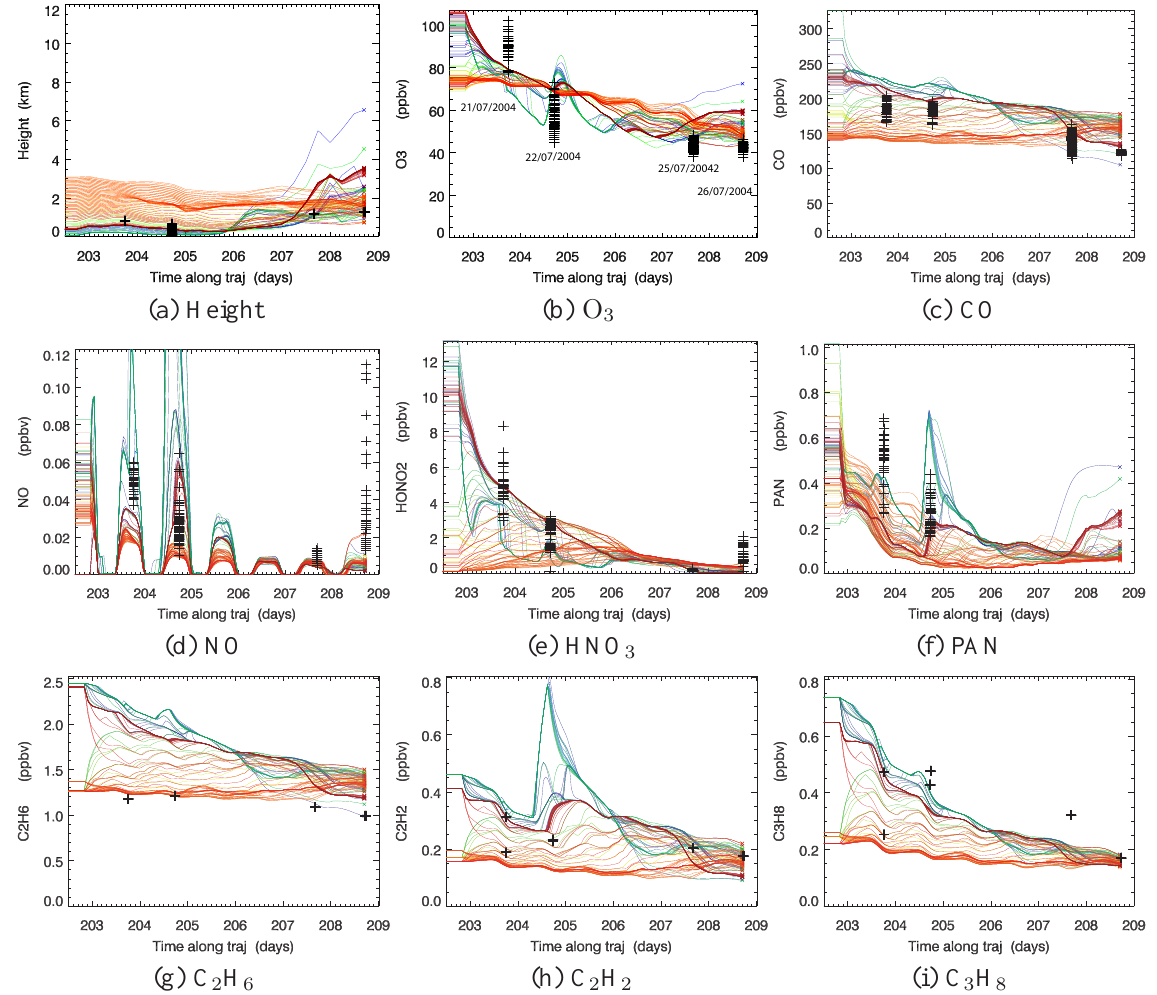
Fig. 3. Case 3 ensemble of trajectories for the simulation with doubled dry deposition. Trajectories are coloured by their release time from the flight track on 20 July 2004 so that individual trajectories can be distinguished. Dark green trajectories are initialised at the lowest altitudes, bright red at the highest. Other details as in Fig. 1.